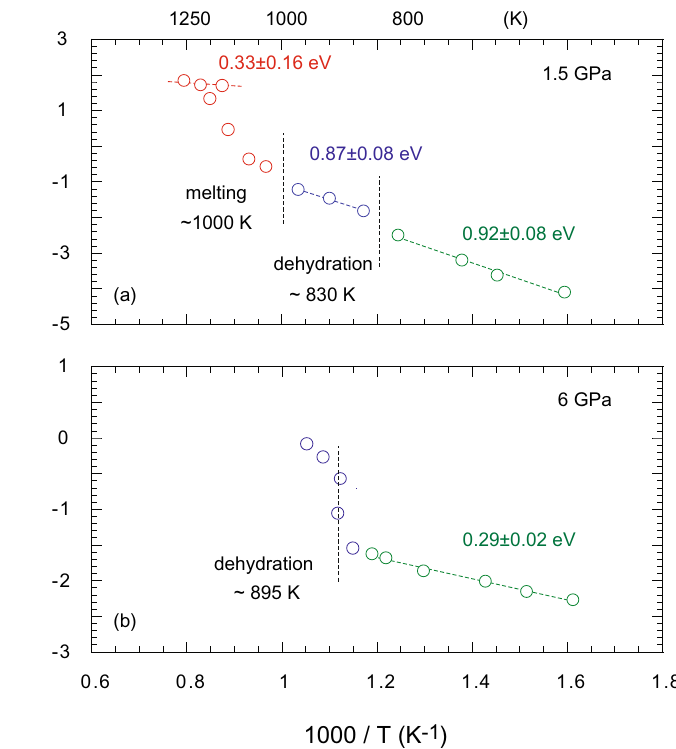
Figure 1. The electrical conductivity of glaucophane as a function of reciprocal temperature. (a) At 1.5 GPa, electrical conductivity is characterized by three stages, separated by discontinuous increases of conductivity at ~ 825 K and 1000 K. (b) Electrical conductivity of glaucophane at 6 GPa. The dehydration of the sample occurs at 895 K. The activation enthalpies corresponding to the dominant conduction mechanism at each stage are shown next to the fitting lines. The experimental uncertainty can arise from the estimation of temperature, geometrical parameters. Fitting errors are estimated to be less than 5% and are smaller than the symbol